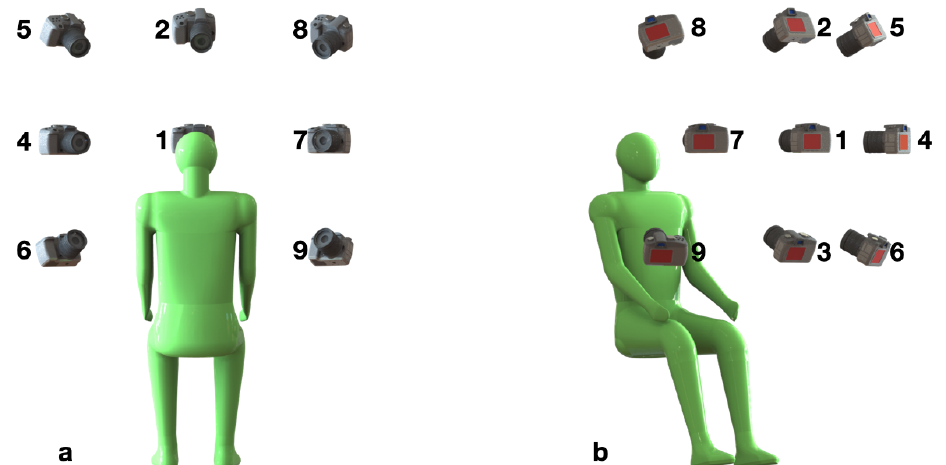
Figure 3. The 3D diagram of the nine camera positions with respect to a subject. ( a ) Back view. ( b ) Side view.